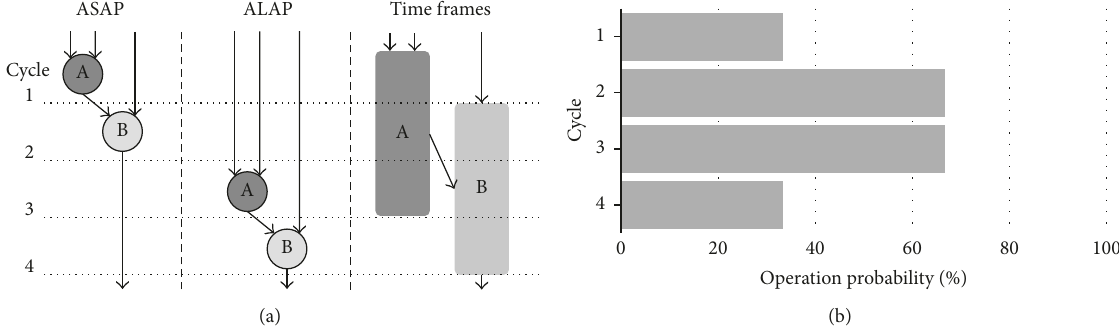
Figure 2: Illustrations of different structures used in Force-Directed Scheduling. The diagram in (a) shows the ASAP and ALAP schedule of a DFG and the respective time frames of the operations. The chart in (b) shows the distribution graph assuming both operations use the same resource type.